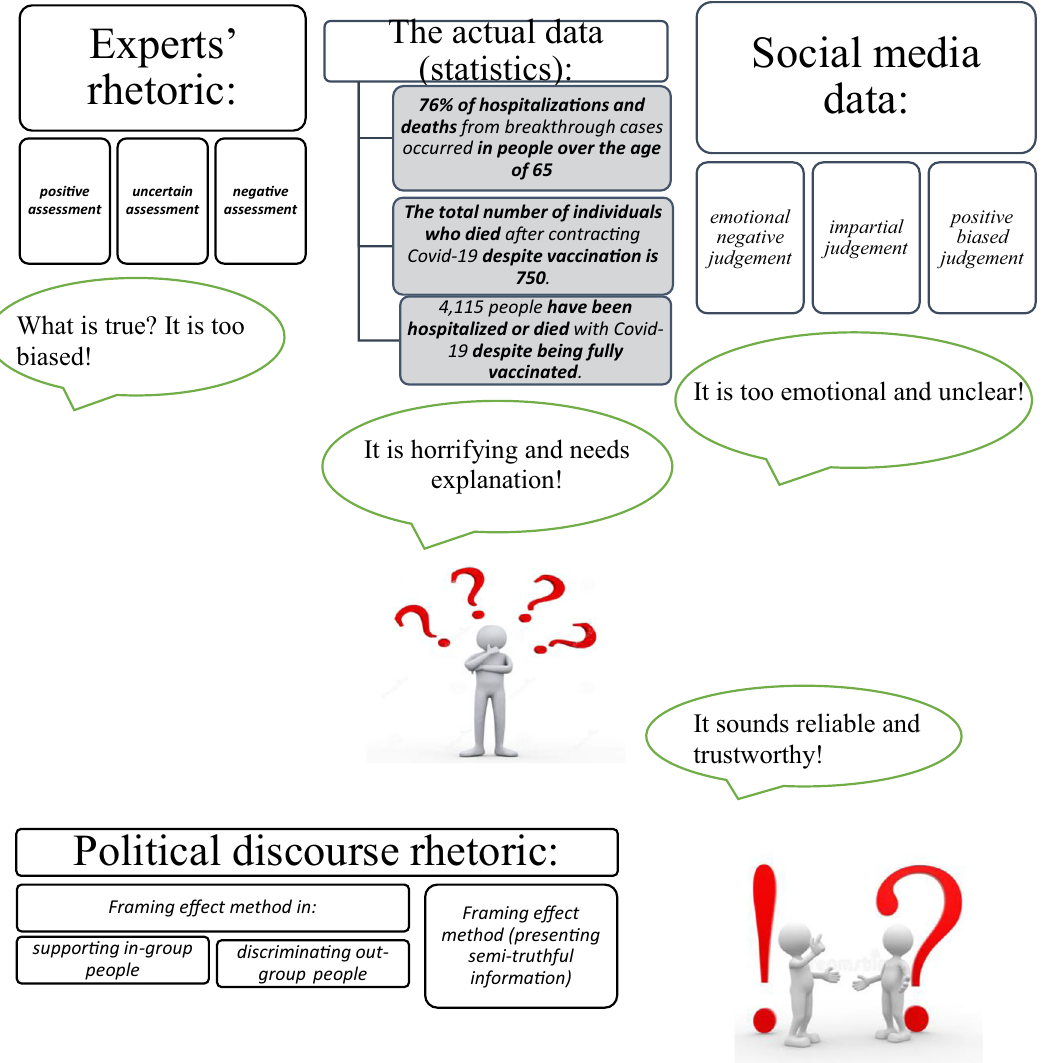
Fig. 1 An individual ’ s choice between different discourse data. A person has to choose among contradictive options. While the experts ’ rhetoric remains biased, the actual data are horrifying, social media discourse is negatively emotional, contradictory and full of abusive words, and the political rhetoric (when using the strategy of persuasion) tries to avoid threatening information and tells people about the positive effect of vaccination only. The political discourse serves here as the most strategical type of communication in people